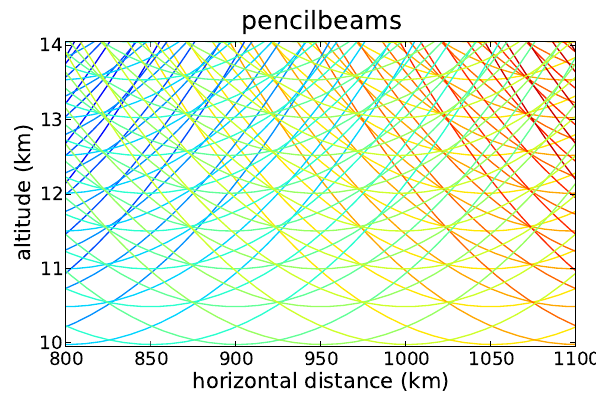
Fig. 3. Line-of-sight (LOS) of the central measurement track in the PREMIER IRLS dynamics mode. LOS belonging to the same image are assigned the same colour. Note that the plot shows only a minor subset of the full simulated atmospheric slice of 6000km times